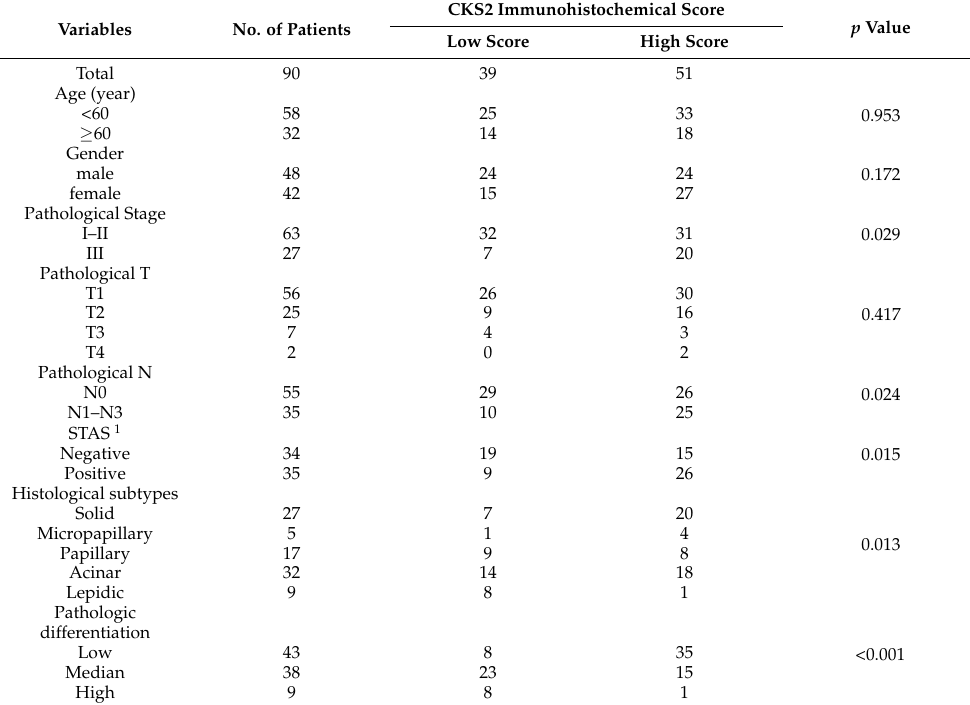
Table 1. Association between CKS2 immunohistochemical score with clinicopathologic parameter.